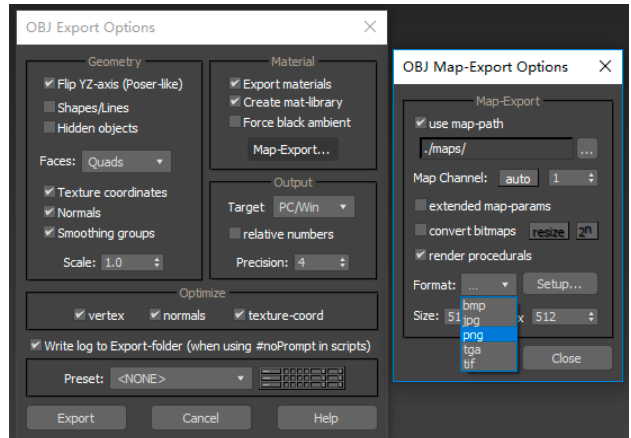
Figure 6. The parameters in the OBJ export option.